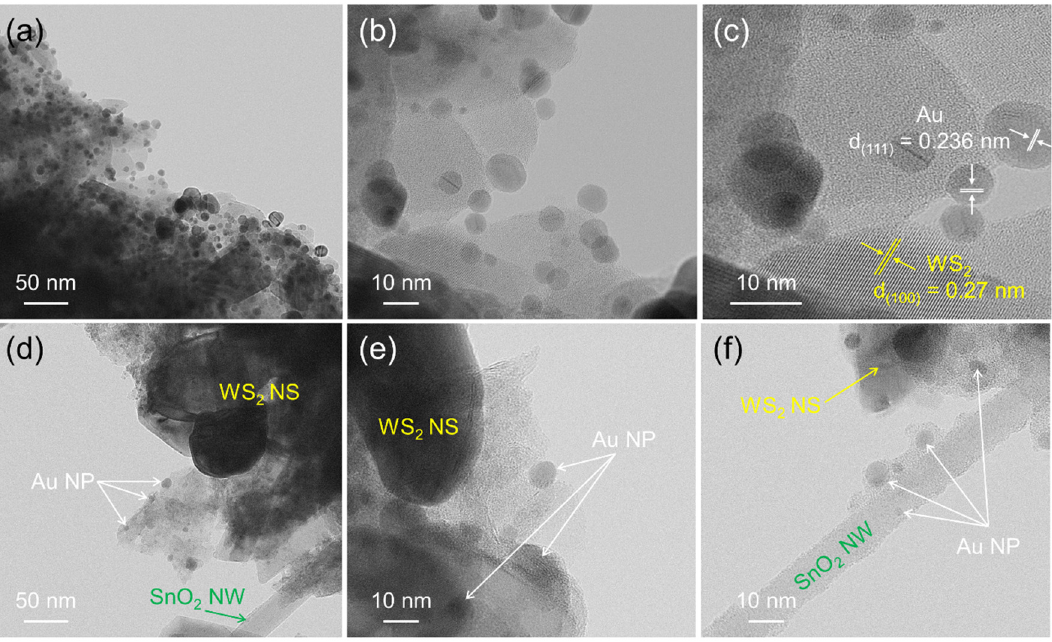
Figure 2. TEM analyses of ( a – c ) Au-decorated WS 2 NSs and ( d – f ) Au-decorated SnO 2 –WS 2 compo-